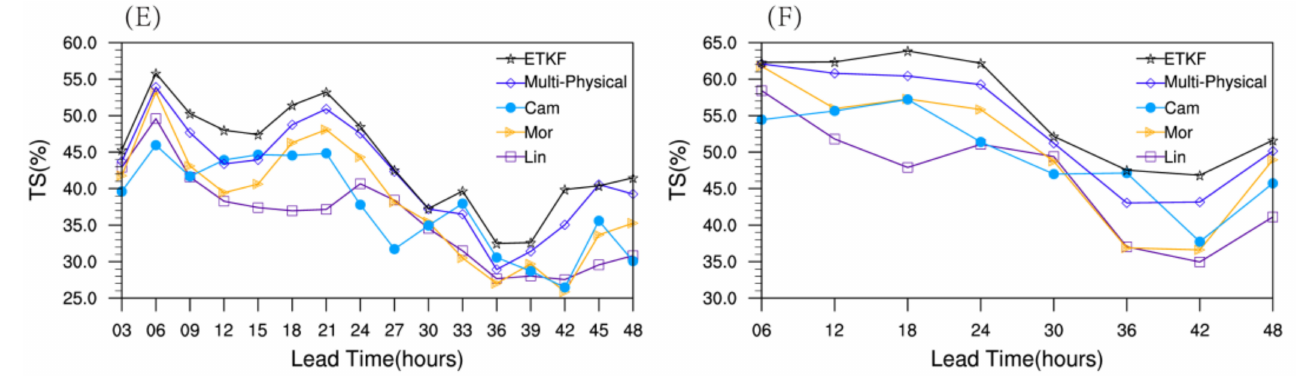
Figure 7. The ACC, RMSE, and threat scores of the ( A , C , E ) 3-hour and ( B , D , F ) 6-hour accumulated precipitation simulated by three schemes and two ensemble methods for different forecast lead